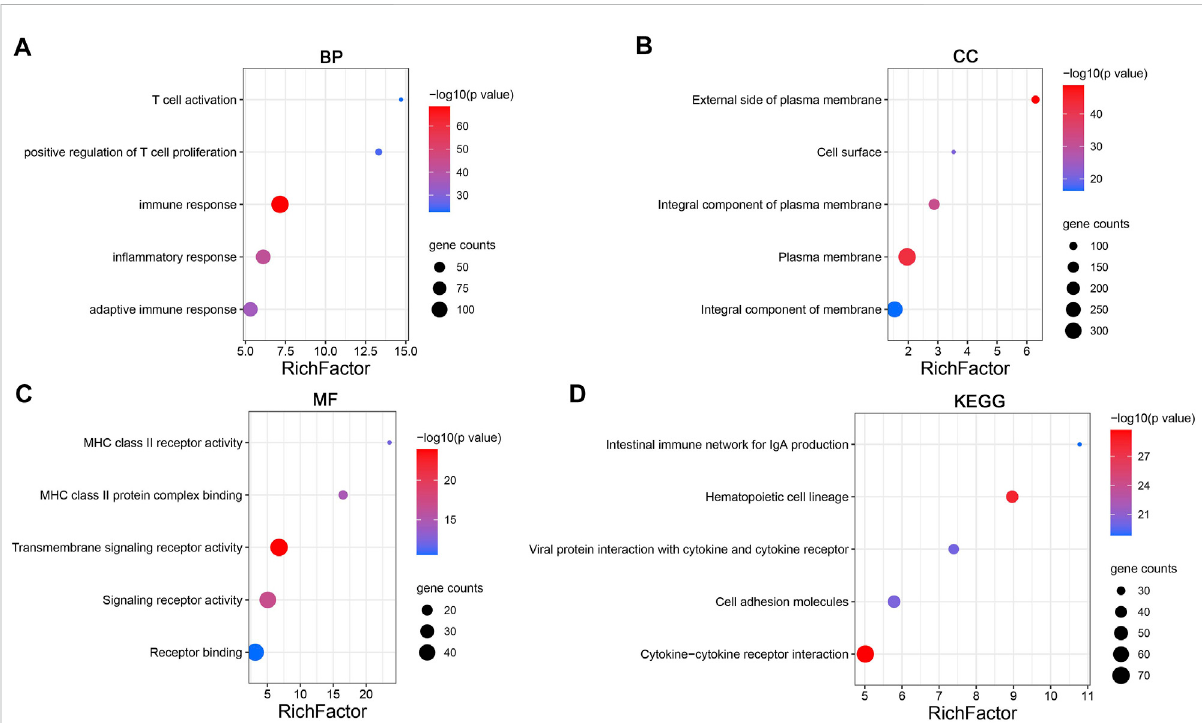
FIGURE 5 Enrichment analysis of CD161 co-expression gene network in BC. (A – C) Bubble plots displayed the top 5 BP, MF and CC terms that were signi fi cantly associated with CD161 co-expression genes. (D) Bubble plots displayed the top 5 KEGG enrichment pathways that were signi fi cantly associated with CD161 co-expression genes. X -axis: the ratio of genes belonged to the corresponding terms/pathways versus the whole co- expression genes. Y -axis: the top 5 GO terms/signi fi cant enrichment pathways. The color gradient of the bubble referred to the enrichment p -value, and the size of the bubble referred to the number of co-expression genes in corresponding GO terms/pathways. BP, biological progress; CC, cellular component; MF, molecular function; GO, Gene